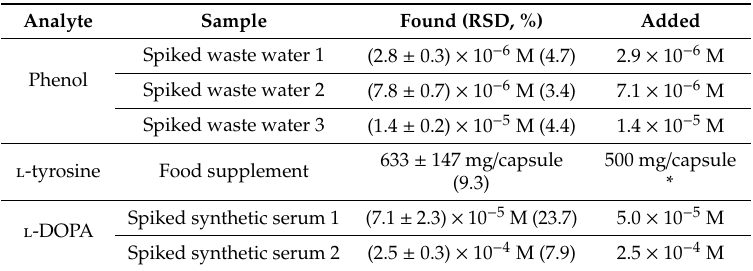
Table 6. Phenolic compounds determination ( n = 3, p = 0.95).